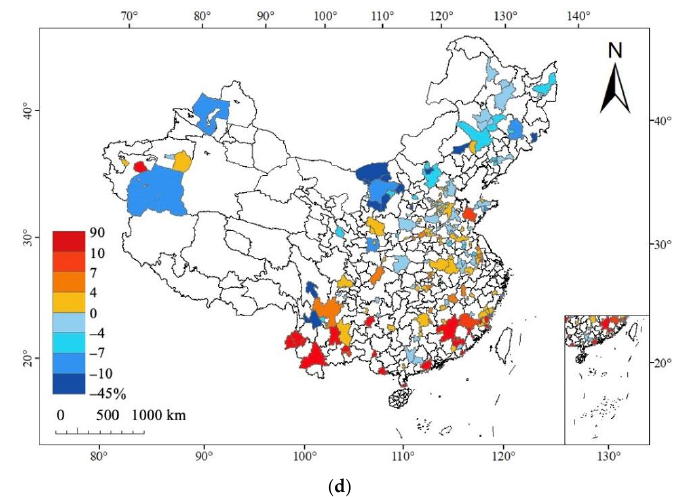
Figure 5. Cooling and heating load-related electricity consumption simulated with ( a ) urban air temperature and ( b ) rural air temperature. ( c ) The differences between urban electricity consumption ( EC u ) and rural electricity consumption ( EC r ) indicate the effect of UHII on electricity consumption in a typical residential building. ( d ) The relative change in electricity consumption due to UHII, i.e., ( EC u − EC r )/ EC r .